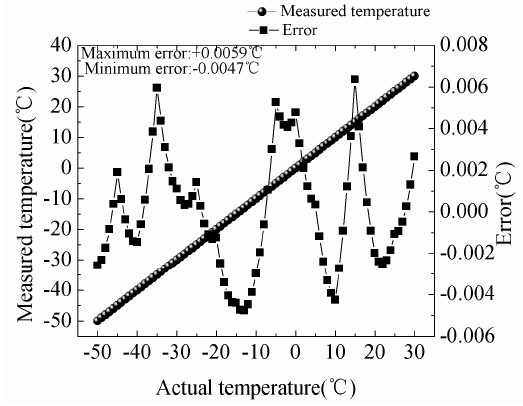
Figure 10. Measured temperature of the thermistor string.